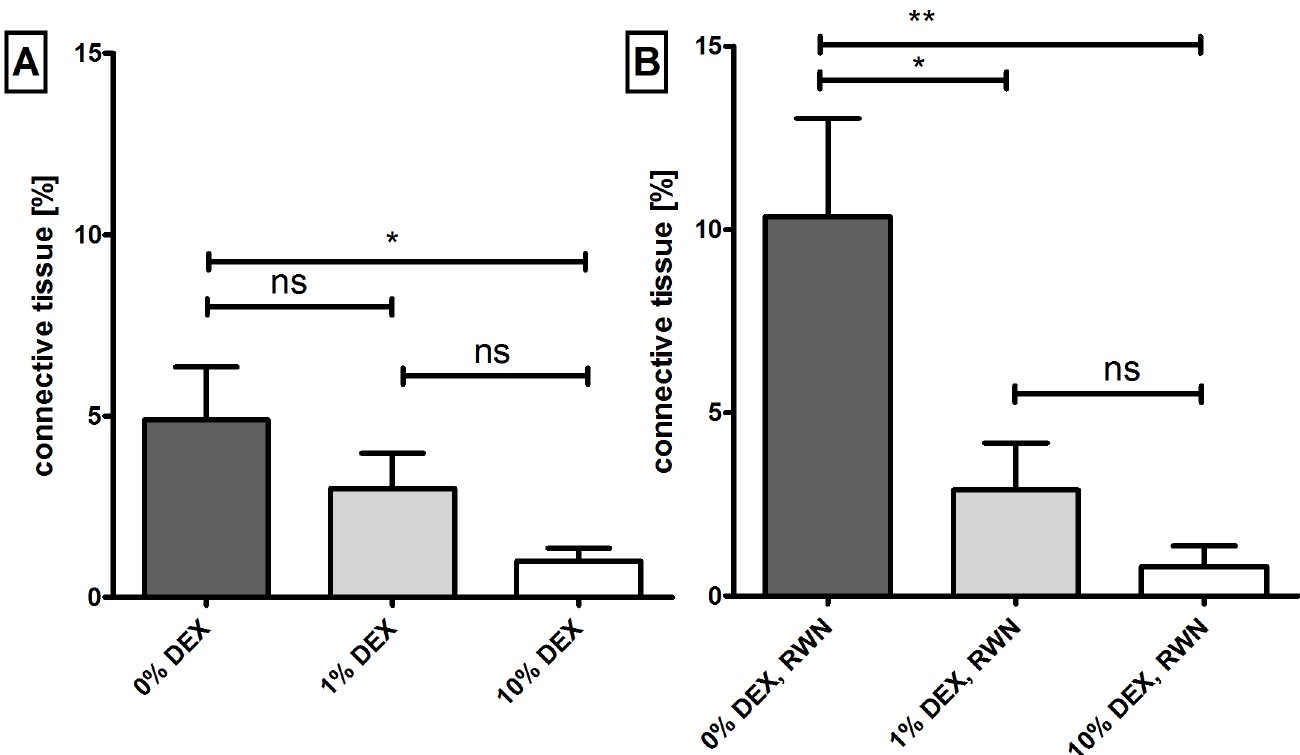
Fig 9. Connective tissue formation in the scala tympani of implanted animals treated with 1%, 10% or 0% DEX (control). Tissue growth is plotted as the percentage area filled in the scala tympani. Sector A illustrates the mean tissue growth for the whole cochlear length analyzed (basal turn) showing a significant difference between the 10% DEX treated cochleae and 0% DEX ( * = p < 0.05). Comparing the tissue reaction at the RWN (B), significant differences are observed for both DEX groups compared to 0% DEX. Statistical differences were denoted; ** = p < 0.01; ns = not significant. Horizontal bars represent the SEM.